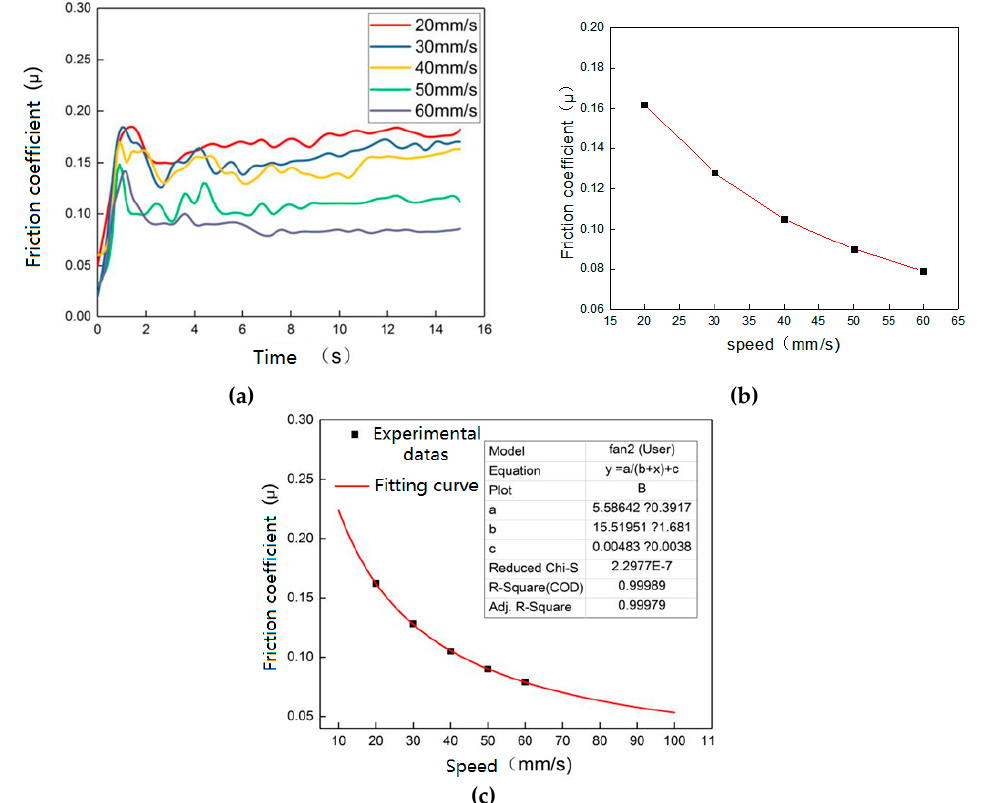
Figure 5. The fluctuation curve of the friction coefficient according to sliding speed: ( a ) Variation curves of the friction coefficient over time under different speeds; ( b ) Experimental friction coefficients under different speeds; ( c ) Inverse function fitting curve. Table 3. Friction coefficient measurement and function model prediction.